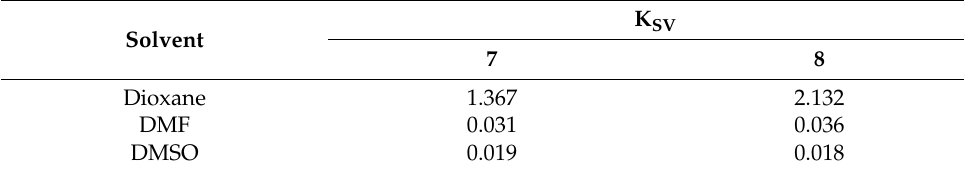
Table 10. Quenching parameters for naphthalimides in solvent/water